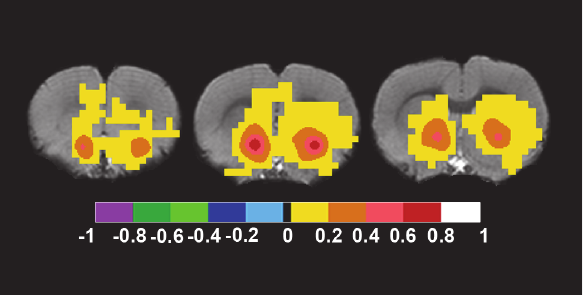
Fig 8. Rat Ventral Basal Ganglia Network. This network was detected by placing the bilateral seed in approximately Bregma in mm: +/-1.5; 6.5; 1.7. Axial rat brain images are sorted from left to right in rostral to caudal order. The image to the far left shows bilateral lower positive FC-values in prefrontal cortex, and bilateral higher positive FC-values in the nucleus accumbens. The middle image shows bilateral positive FC- values in nucleus accumbens, and lower positive FC-values in medial caudate putamen as well as prefrontal cortex. The image to the far right shows positive FC-values in nucleus accumbens and lower positive FC- values in caudate putamen. FC-values are displayed with a pseudo-colored scale bar; with increments of 0.2 each designated a color (see the color-bar in the